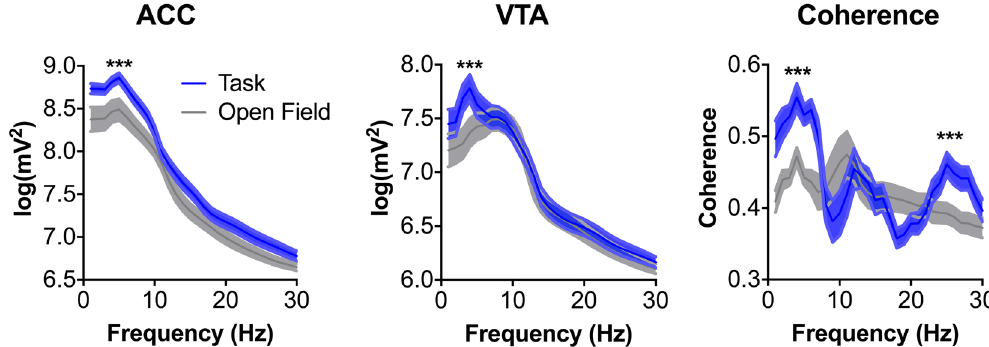
Figure 3. ACC and VTA power and coherence in the 3–5 Hz band were significantly greater during the task as compared to recordings taken during open field recordings collected immediately before or after each data collection session. Although comparisons were computed for each animal separately (n = 9 paired open field and task recordings per animal), the data here are presented as the grand mean ± SEM across all animals (n = 5